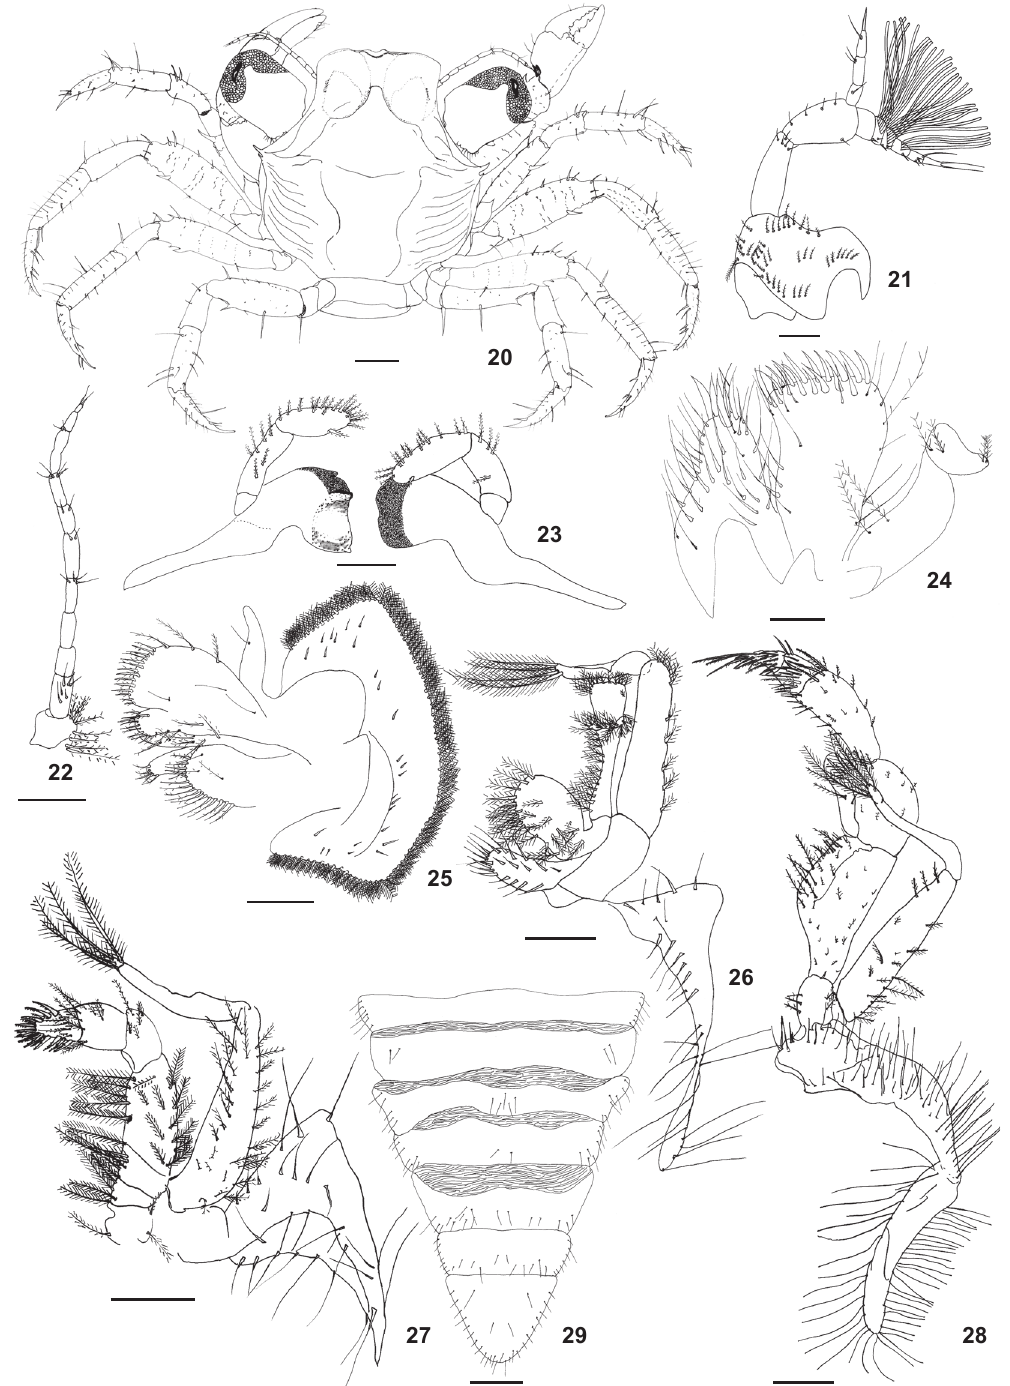
Figures 20-29. Pachygrapsus gracilis , juvenile I appendages: (20) dorsal view; (21) antennule; (22) antenna; (23) mandible; (24) maxillule; (25) maxilla; (26) 1 st maxilliped; (27) 2 nd maxilliped; (28) 3 rd maxilliped; (29) abdomen. Scale bars: 20, 26 = 0.02 mm; 21, 23, 25 = 0.006 mm; 22, 27-29 = 0.01 mm; 24 = 0.08